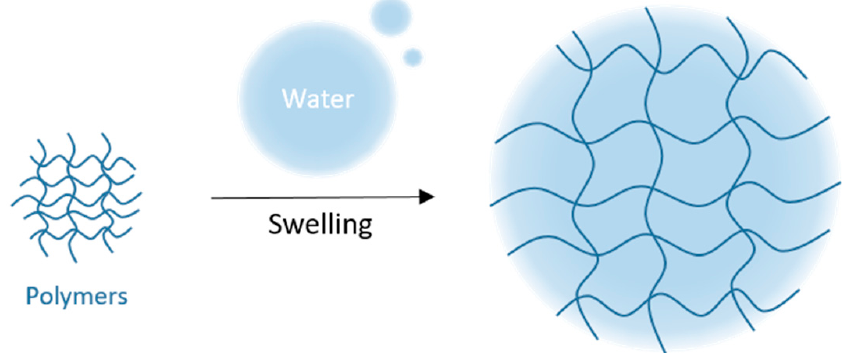
Figure 1. Hydrophilic gel formation by swelling of polymers in water.